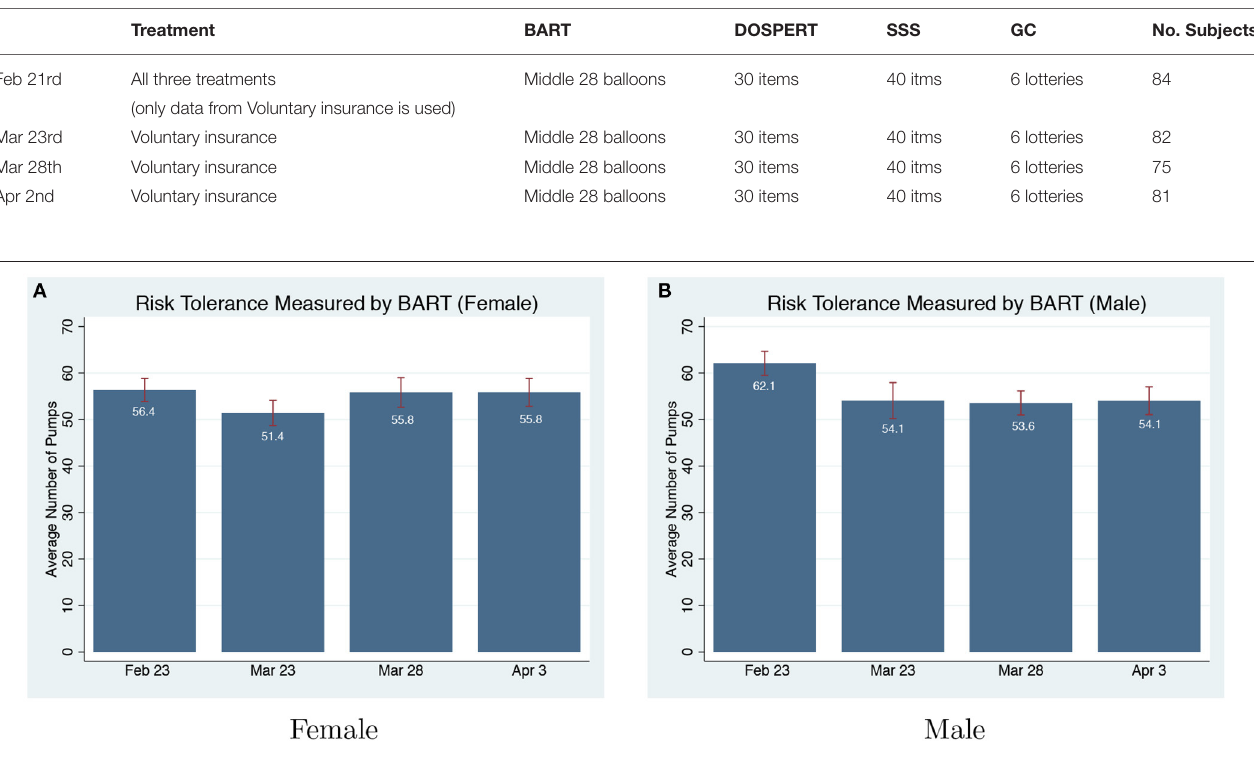
FIGURE 1 | Risk-taking measured by Balloon Analogue Risk Task (BART) pre and on-pandemic. (A) Risk tolerance measured by BART (Female). (B) Risk tolerance measured by BART (Male).